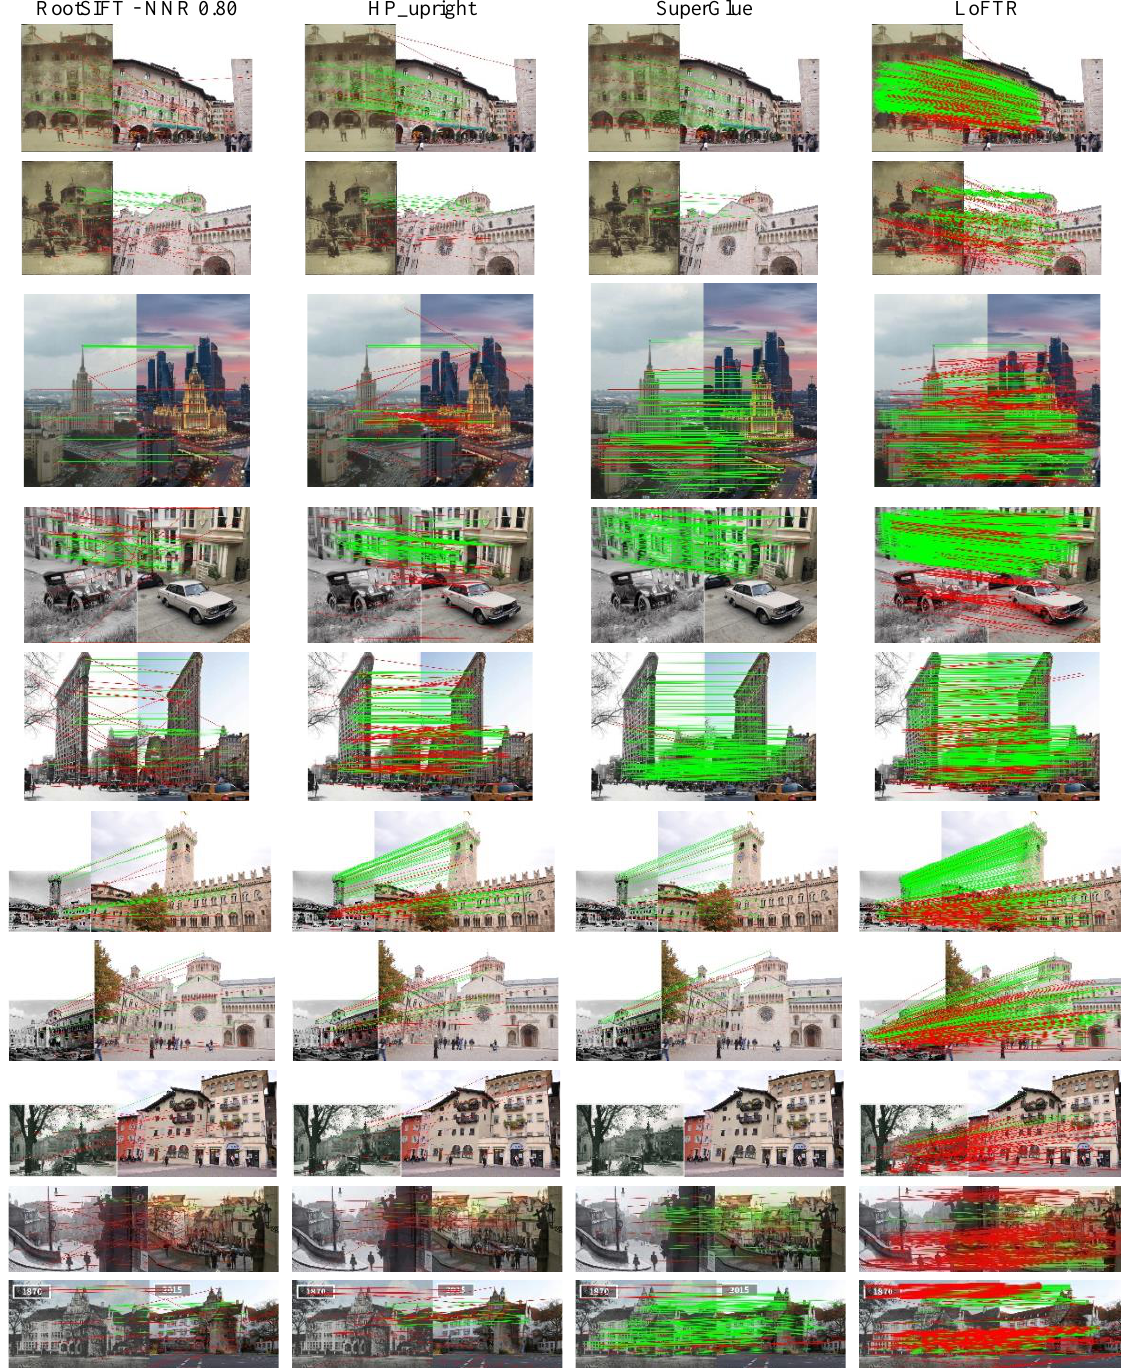
Figure 5: Correct (green) and wrong (red) matches for RootSIFT, HP_upright, SuperGlue and LoFTR on the employed image